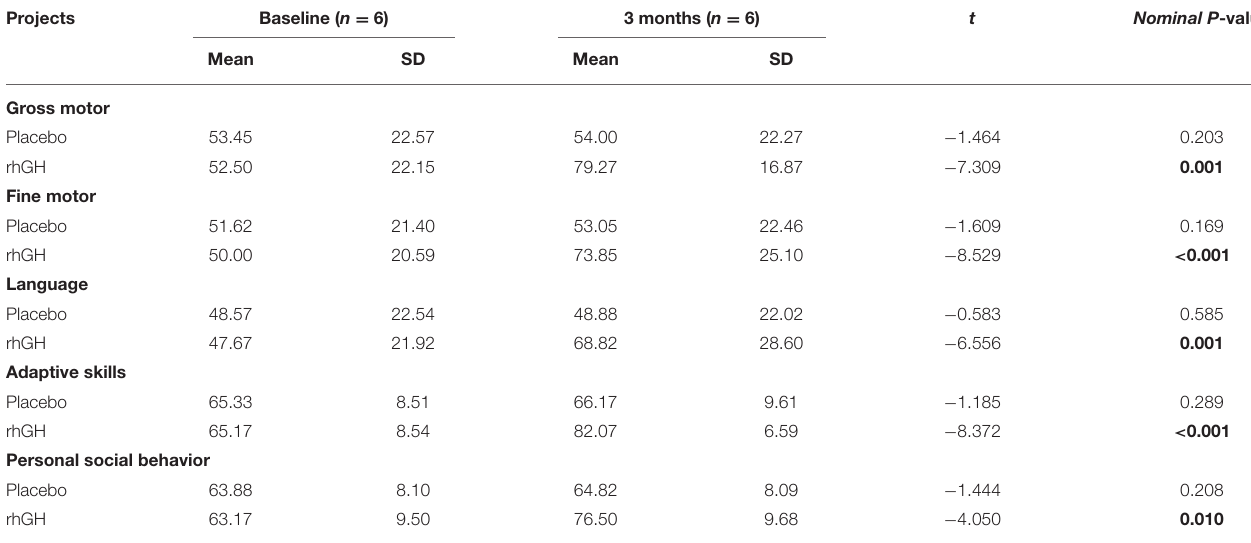
TABLE 5 | Comparison of the subscale scores of the GDS before and after treatment.